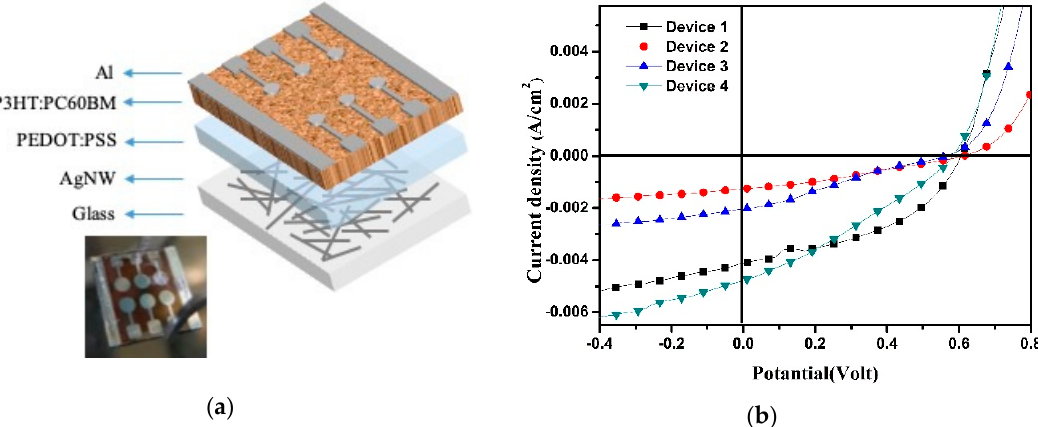
Figure 6. ( a ) Structure and ( b ) J–V curves of the devices with ITO or AgNWs as the anode under illuminated AM 1.5 G. Table 2. Photovoltaic parameters of the devices based on ITO and LBL assembled AgNWs as the anode.